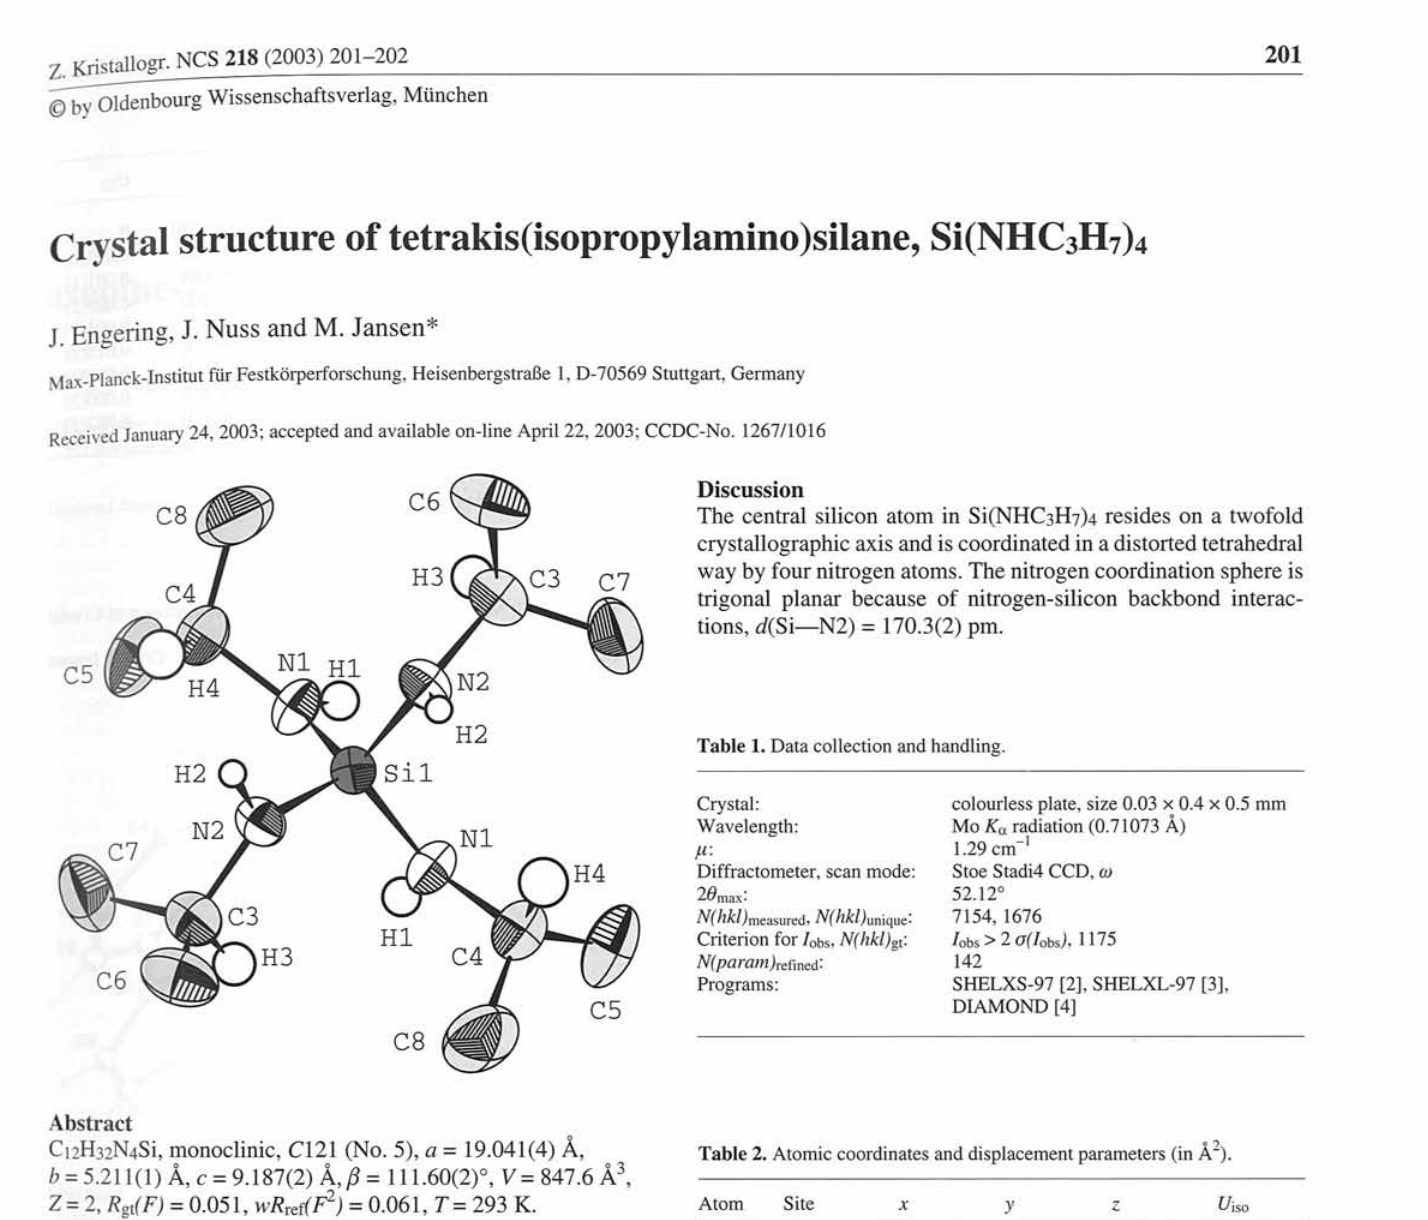
Table 2. Atomic coordinates and displacement parameters (in À 2